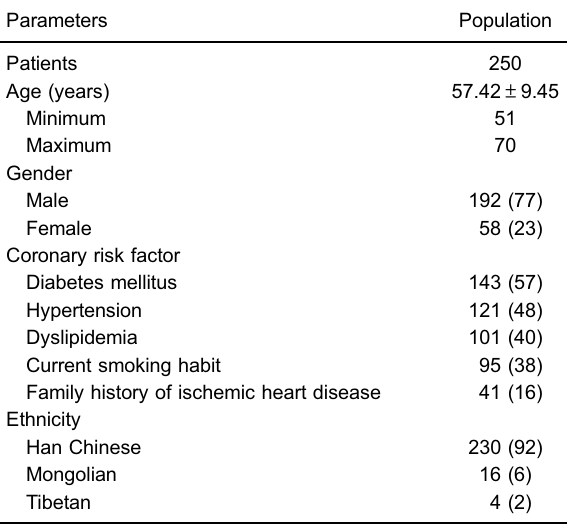
Categorical data are reported as frequency (percentage) and numerical data as means ±